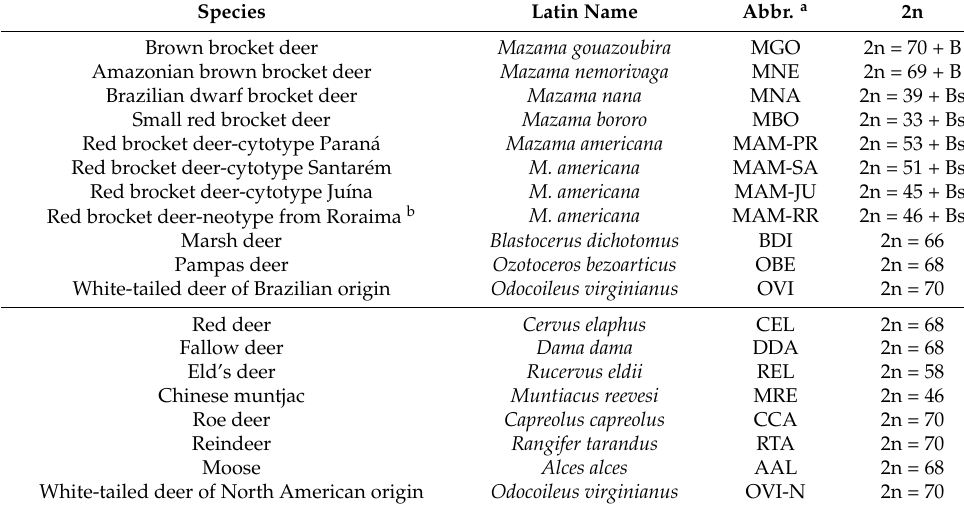
Table 1. Species analyzed in this